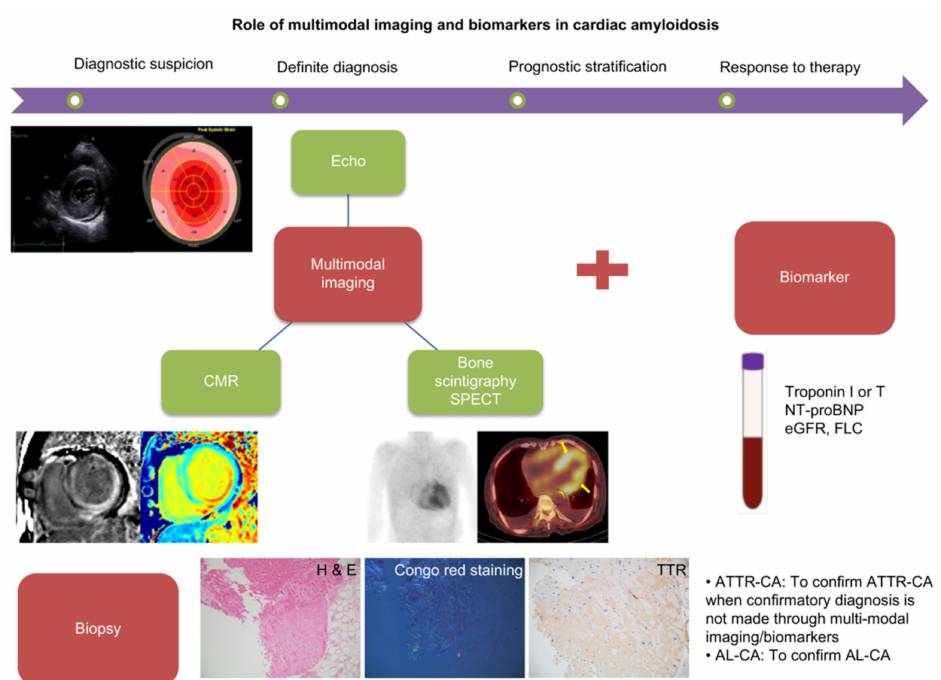
Figure 5. Role of multimodal imaging and biomarkers in cardiac